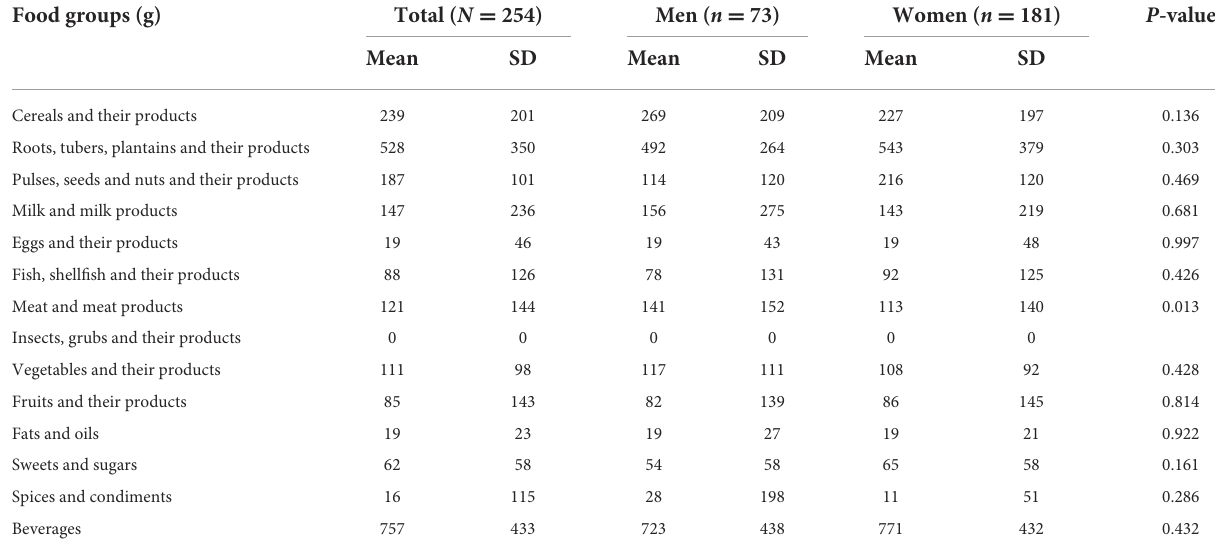
TABLE 3 Usual intake of different food groups by